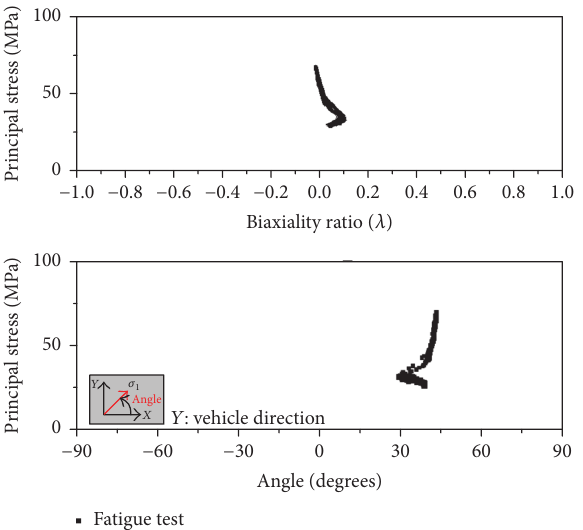
Figure 15: Changes in principal stress in fatigue test (Point 3).